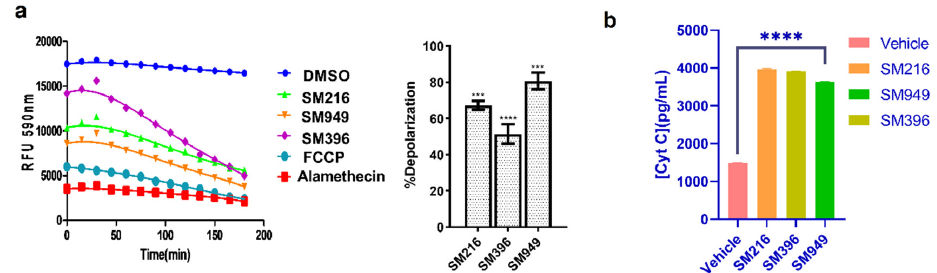
Figure 4. SM216, SM396, and SM949 induce apoptosis via mitochondrial membrane depolarization and Cytochrome C release in MDA-MB-231 cells. ( a ) Dynamic BH3 profiling assay using JC-1 staining on MDA-MB-231 cells treated with the compounds. ( b ) Analysis of Cytochrome C release (Cyt C) by ELISA. The dosage used for the assay was as follows, SM216: 1.866 µ M, SM396: 2.995 nM, and SM949: 0.1875 µ M. ****, *** represent p ≤ 0.0001 and p ≤ 0.001,